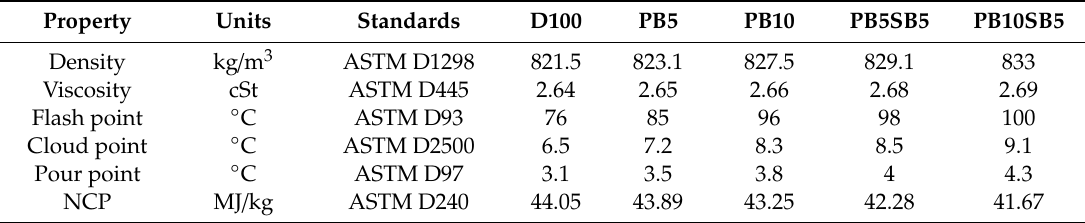
Table 4. Physicochemical properties of the